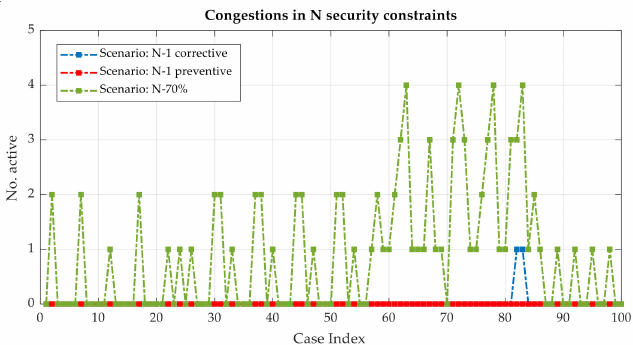
Figure 11. Congestions identified by N security